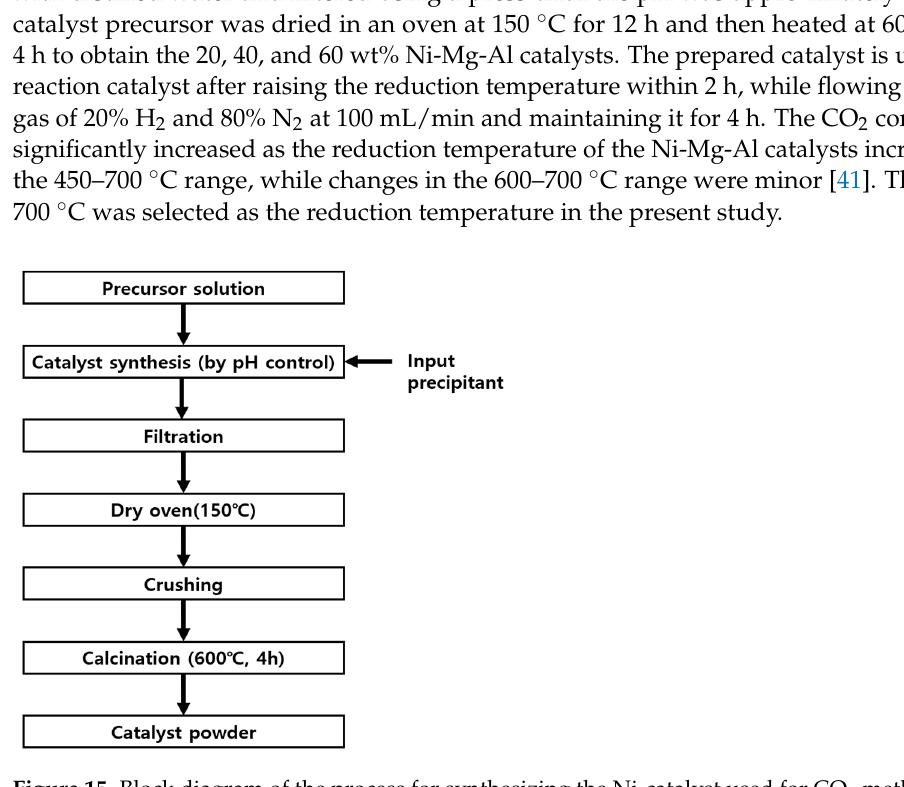
Figure 15. Block diagram of the process for synthesizing the Ni-catalyst used for CO 2